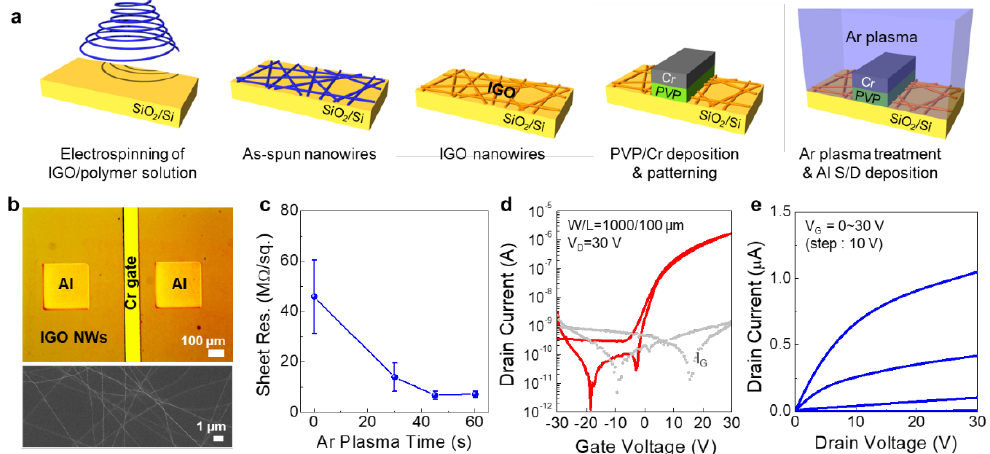
Figure 5. ( a ) Fabrication process of self-aligned top-gate IGO NW TFTs. The IGO NW channel was fabricated using an electrospinning process. ( b ) An optical image of IGO NW TFT and a FESEM image of the IGO NW channel. ( c ) The variation of IGO NW film as a function of Ar plasma time. ( d ) Transfer and ( e ) output characteristics of self-aligned top-gate IGO NW TFTs fabricated with Ar plasma treatment time of 30 s. The channel width and length of 1000 µ m and 100 µ m,